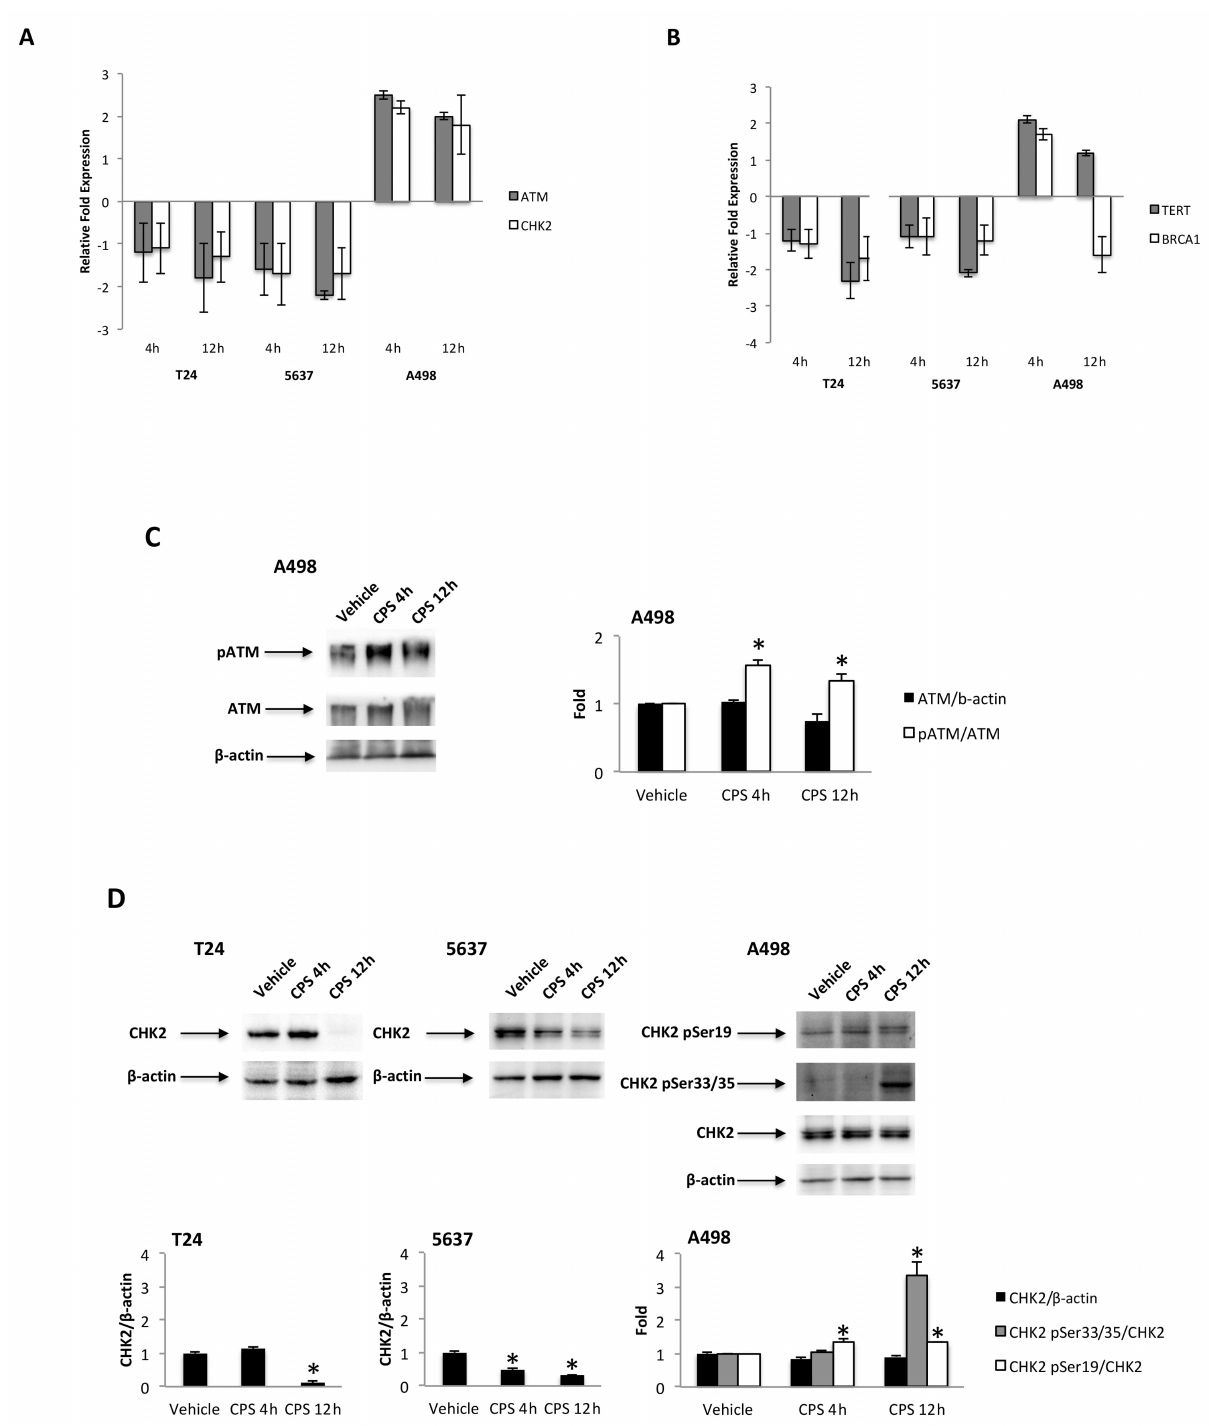
Figure 4. ( A ) Relative ATM and CHK2 mRNA expression in T24, 5637 and A498 cells treated with CPS for 4 and 12 h was evaluated by quantitative reverse transcription (qRT)-PCR. ATM and CHK2 mRNA levels were normalized for GAPDH expression and expressed as the fold with respect to the vehicle. ( B ) Relative TERT and BRCA1 mRNA expression in T24, 5637 and A498 cells treated with CPS for 4 and 12 h was evaluated by qRT-PCR. TERT and BRCA1 mRNA levels were normalized for GAPDH expression. Data are expressed as mean ± SD. ( C ) Immunoblot representative of pATM and ATM protein levels in A498 cell line. pATM densitometry values were normalized to ATM, and